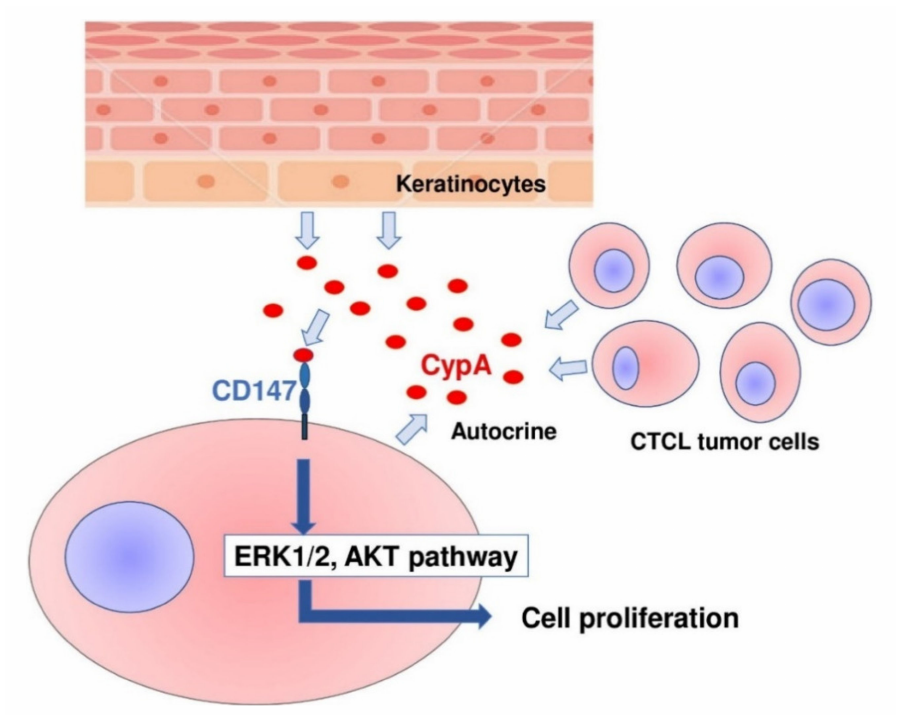
Figure 5. Schematic model of the main findings of this